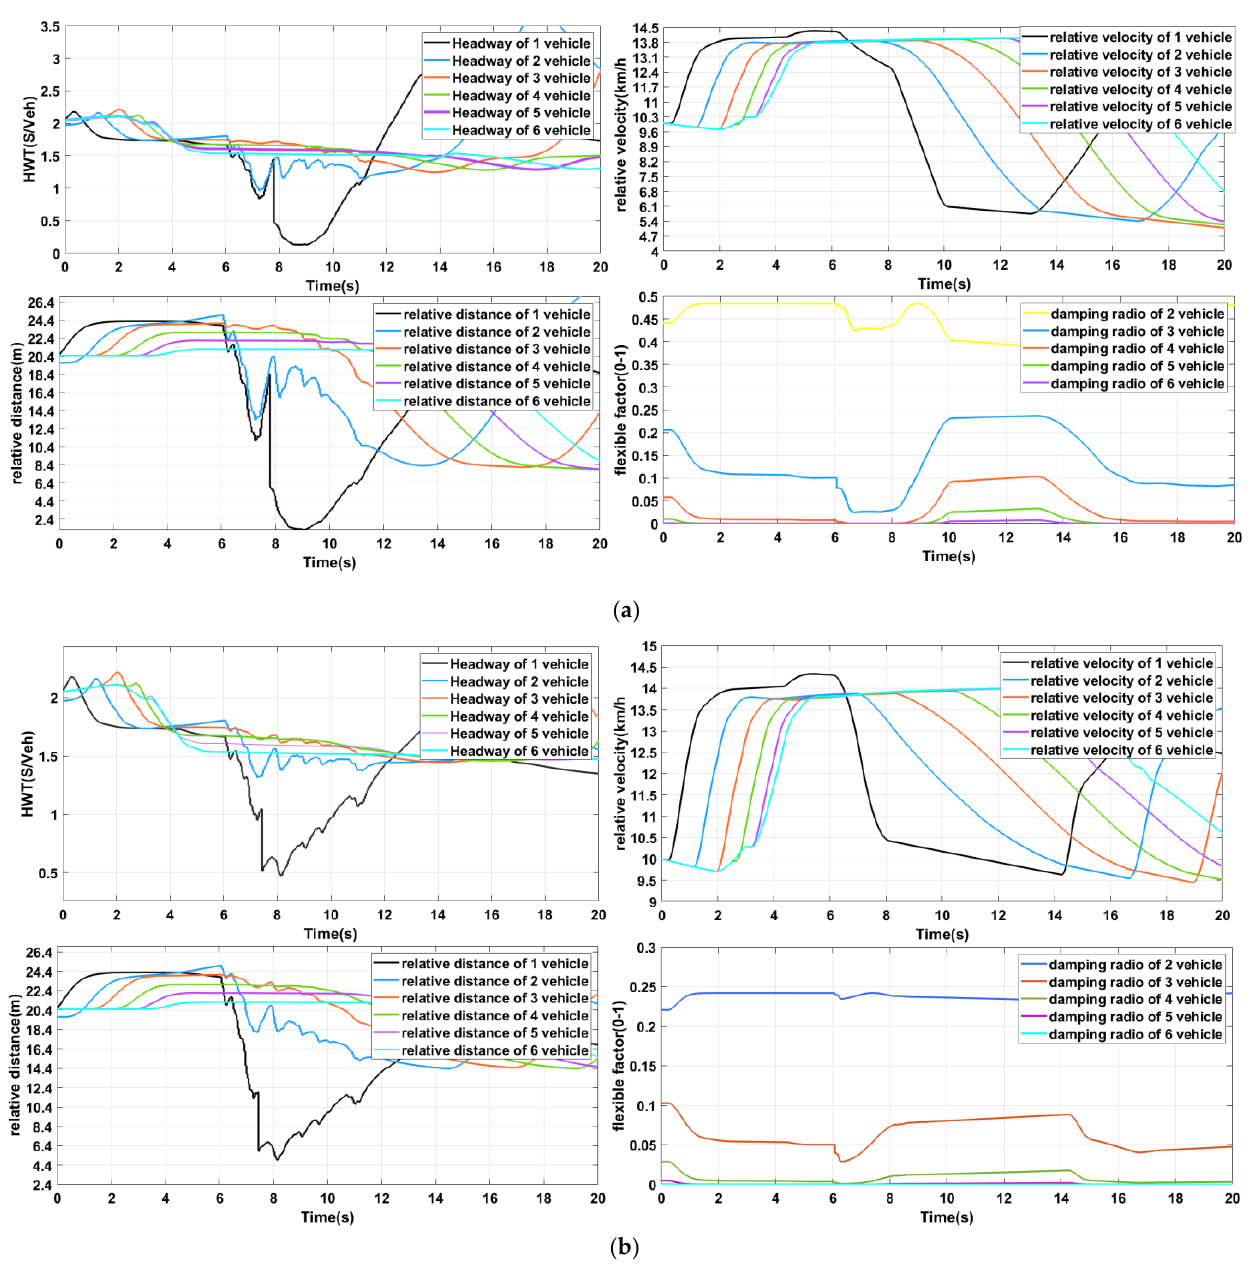
Figure 4. Headway/speed/distance/comfort: ( a ) working condition 1: attenuation factor distribution rate of 0 – 0.5; ( b ) working condition 2: attenuation factor distribution rate of 0 – 0.25.